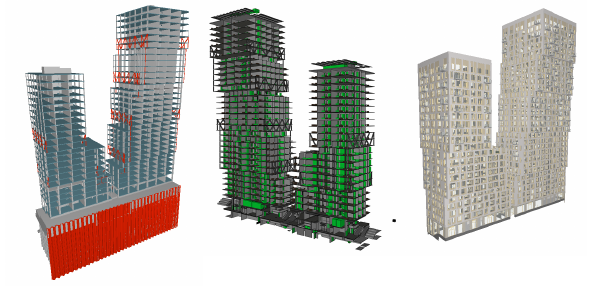
Figure 1. The three IFC models composing the Peak tower BIM, from left to right: structural, architectural and facades. The Terrace tower BIM is represented by structural and archi-